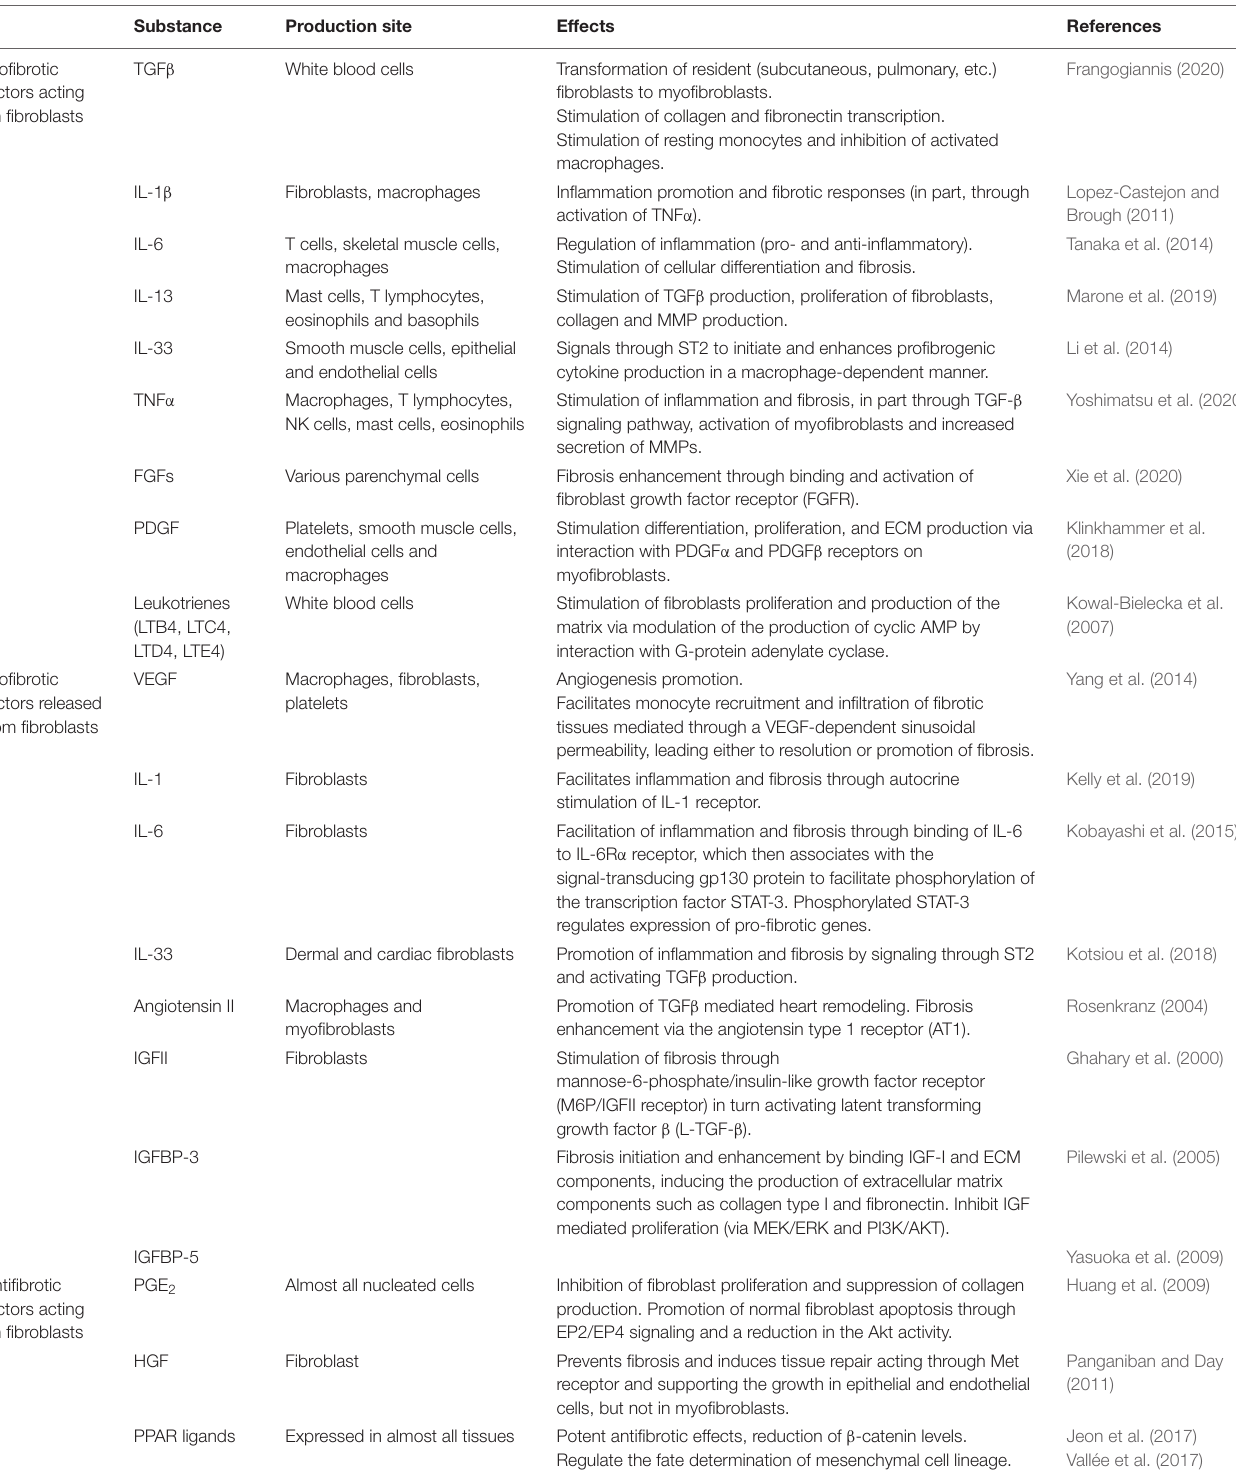
TABLE 2 | Key mediators of inflammation and